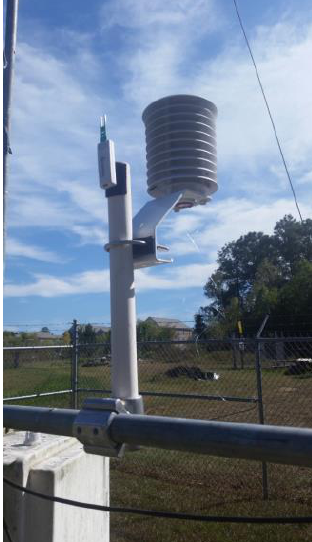
Figure 2. Close-up of iMET-XQ sensors used in the Radiation Shield experiment configuration. The radiation shield contains an iMET-XQ sensor. An exposed iMET-XQ is mounted beside the radiation shield.